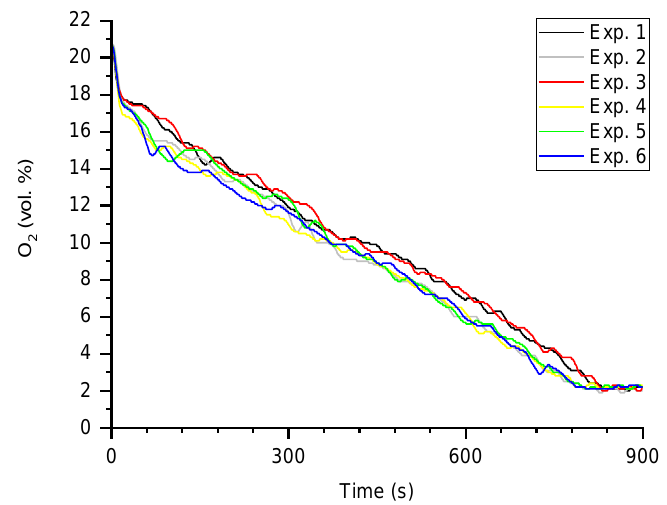
Figure 6. O 2 content in the flue gas for the start-up phase.